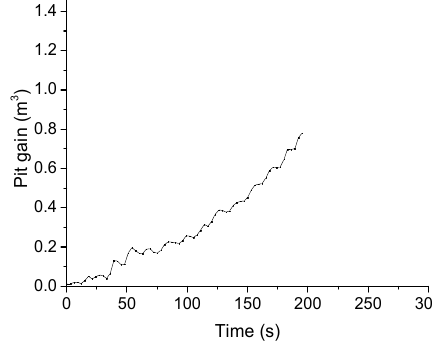
Figure 11. Time sequence diagram of pit gain.